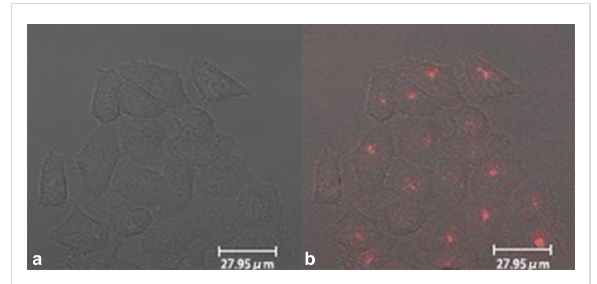
Figure 11: Confocal microscopic images of Panc-1cell treated with micelle encapsulated CdS /ZnS (a) transmission image, (b) overlay image.